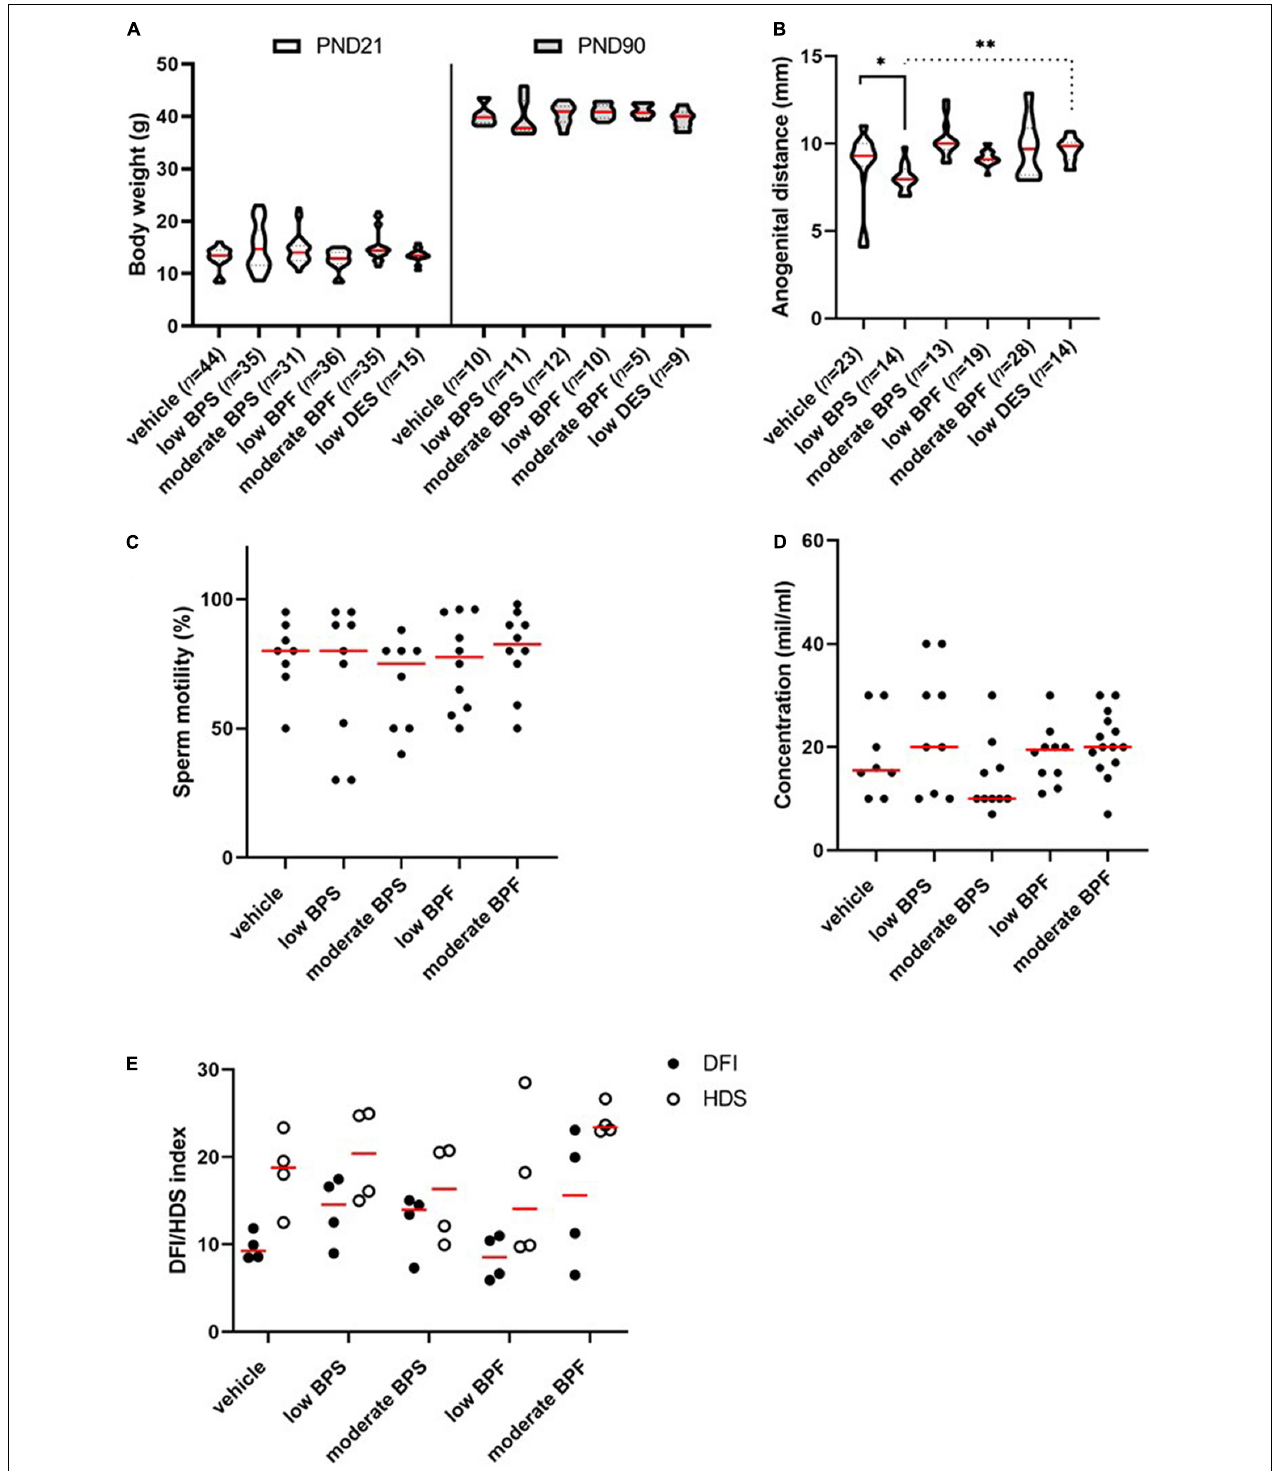
FIGURE 1 | Morphological signs and spermiogram parameters of males exposed to bisphenols via maternal milk. (A) Comparison of weight (g) of male offspring in the post-natal day (PND) 21 and PND 90 in control, low bisphenol S (BPS), moderate BPS, low bisphenol F (BPF), moderate BPF, and low diethylstilbestrol (DES) groups. The shape of violin plots represents the distribution of weight in each experimental group, the red line shows median and dashed lines show quartiles. Numbers of analyzed offspring are indicated in brackets. (B) Anogenital distance (mm) of male offspring in control, low BPS, moderate BPS, low BPF, moderate